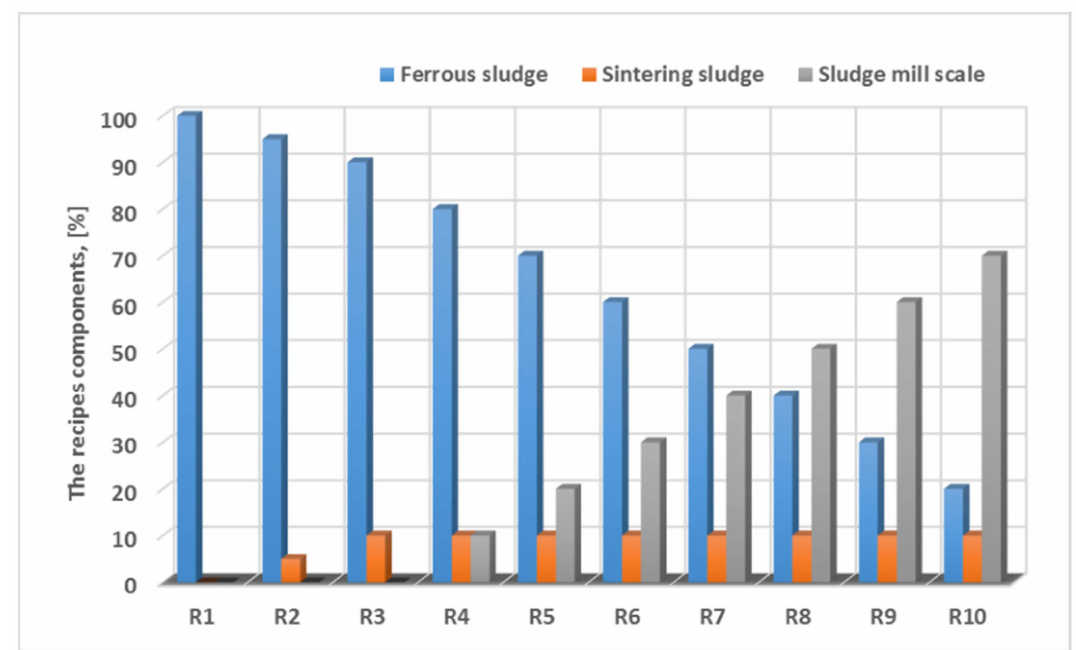
Figure 9. Composition of the experimental recipes.